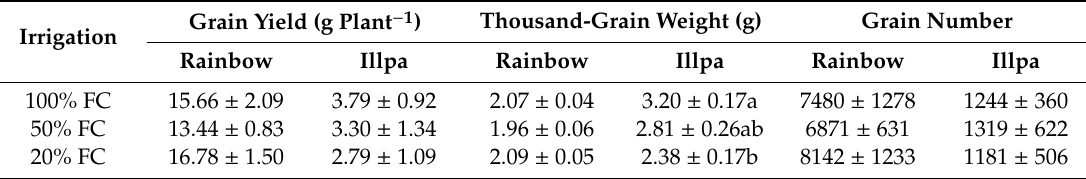
Table 1. Grain yield (g plant − 1 ), thousand-grain weight (g) and grain number in the coastal (Rainbow) and altiplano (Illpa) cultivars grown under irrigation regimes of 100% substrate holding full capacity (FC), 50% FC or 20% FC. The same letters indicate no significant di ff erences between treatments for a given cultivar ( p < 0.05). Mean ± SE ( n = 4–5).